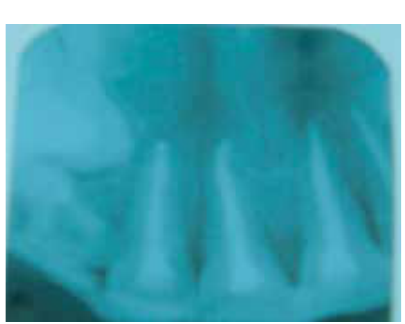
Fig 7. OPG view after RCT and removal of splint Fig 8. Periapical image after six